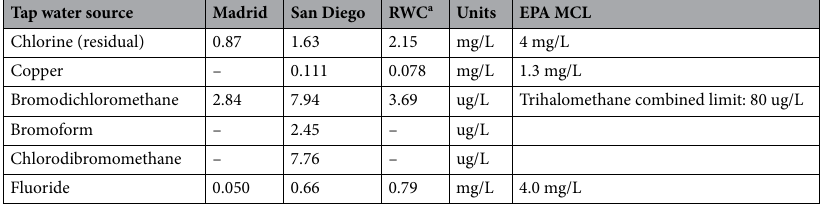
Table 3. Water chemistry panel results on Madrid, San Diego, and Redwood City tap waters (2019). Samples were run in singlicate for all water chemistry analysis. MCL maximum contaminant level. a RWC Redwood